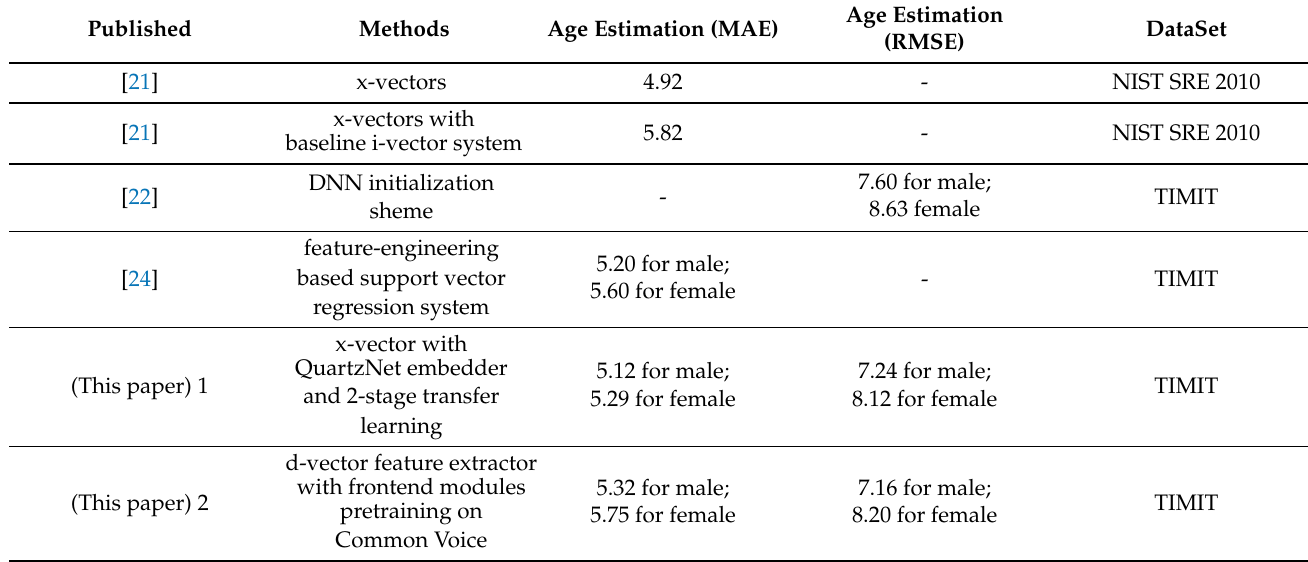
Table 14. Comparison of proposed system with existing ones for age estimation.